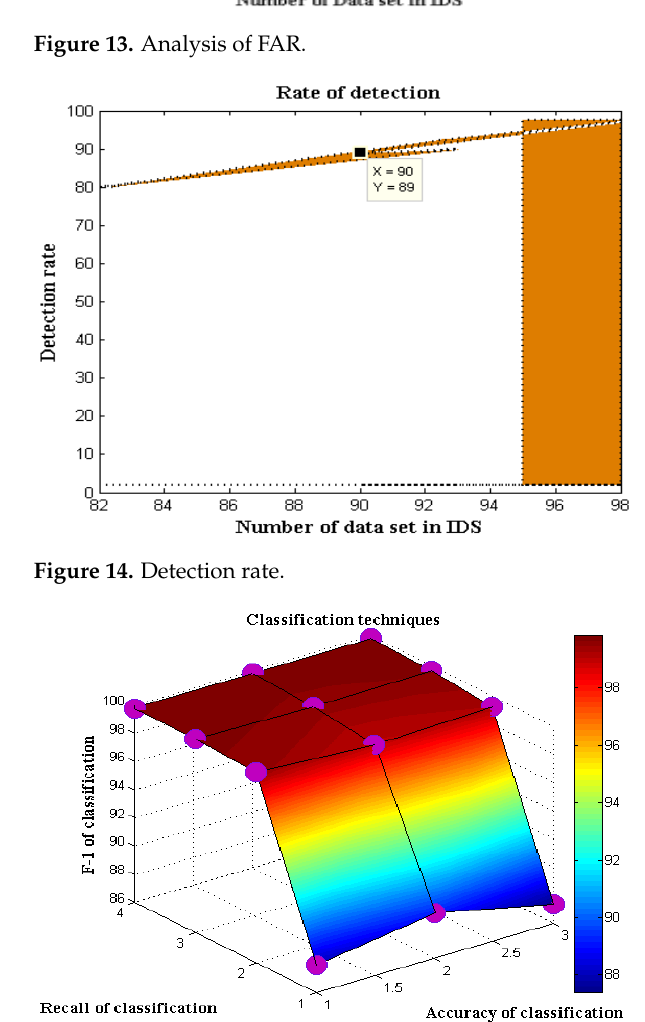
Figure 15. Accuracy, recall, and F1-score analysis.